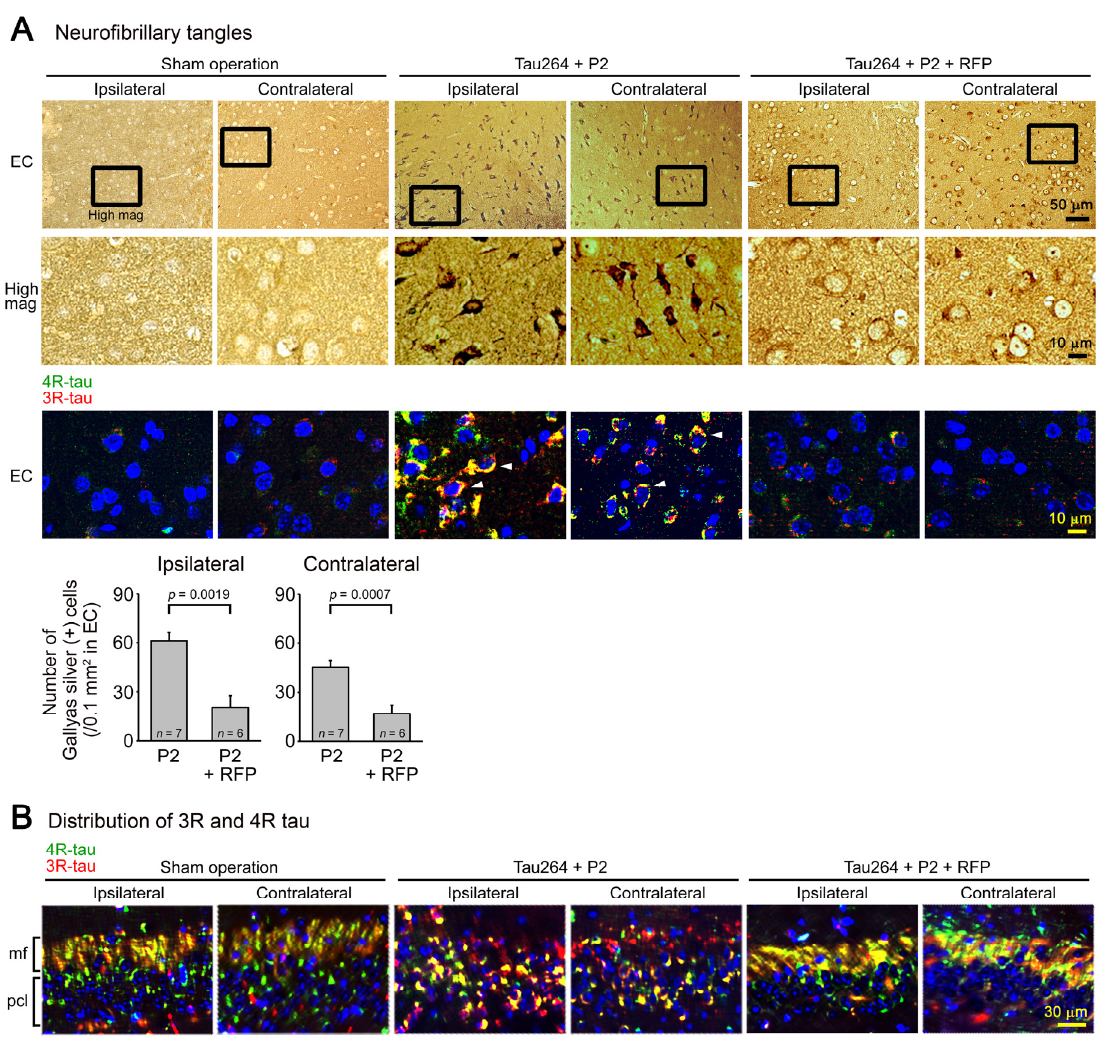
Figure 3. NFT formation and the effects of rifampicin treatment. ( A ) Gallyas silver staining was performed to visualize NFTs. In P2-injected, CMC-treated mice, NFT-bearing neurons were detected in the entorhinal cortex (EC), but not in other brain regions bilaterally. Some neurons showed a shrunk morphology. Immunofluorescence imaging revealed that in these cells, both 3R- and 4R-tau accumulated within the cell bodies (arrowheads). Sham-operated mice did not show these alterations, and rifampicin treatment prevented them. ( B ) In the hippocampal CA3 region, an altered distribution of 3R and 4R tau was observed in P2-injected, CMC-treated mice but not in sham-operated mice: 4R tau disappeared from the mossy fibers (mf), and both 3R and 4R tau accumulated within the cell bodies in the pyramidal cell layer (pcl). Rifampicin treatment prevented this